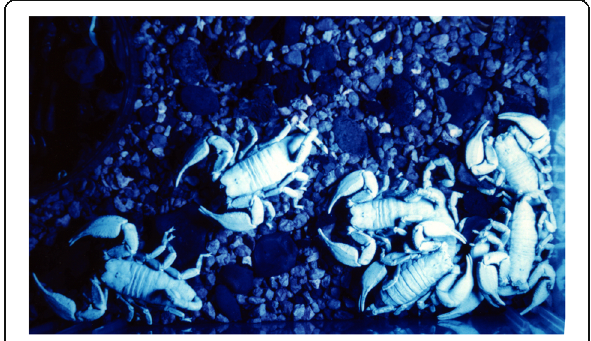
Fig. 13 Female of Chiromachus ochropus from the Seychelles Islands with a huge litter size of first instar pro-juveniles